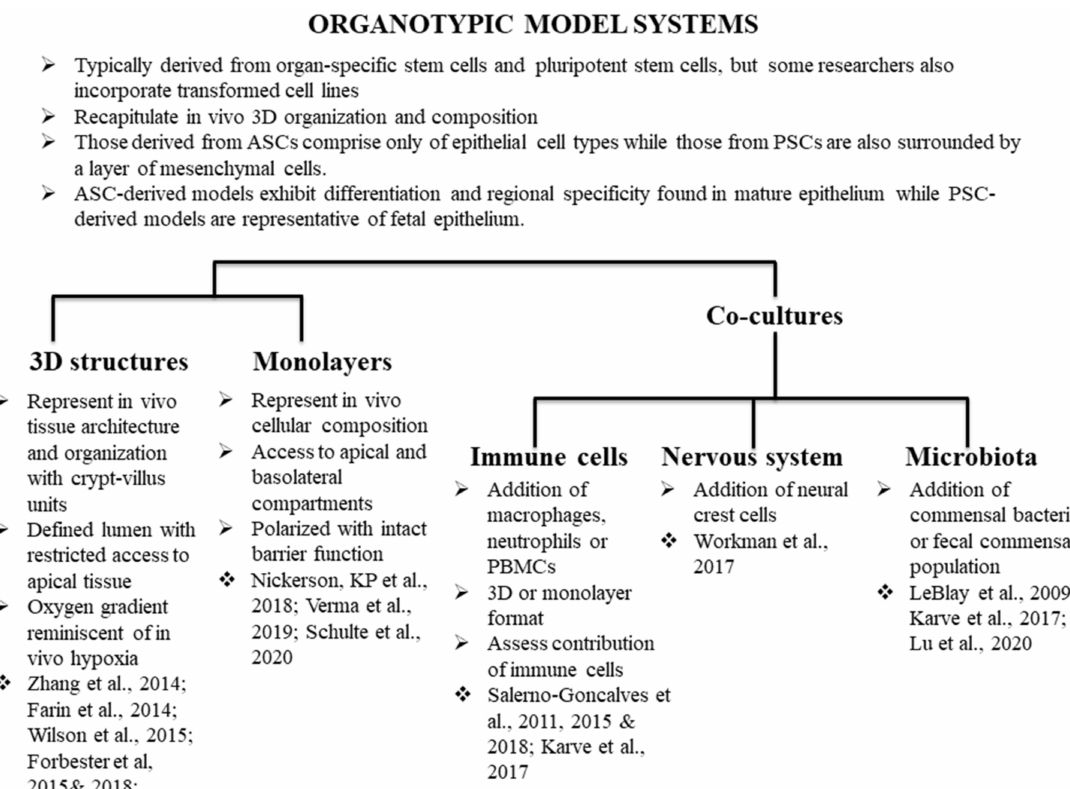
Figure 1. Use of organotypic models in Salmonella biology. We highlight studies that have utilized organotypic models to better understand Salmonella biology, as well as studies that do not directly pertain to Salmonella research but have the potential to be deployed for better understanding of the dynamics of host- Salmonella